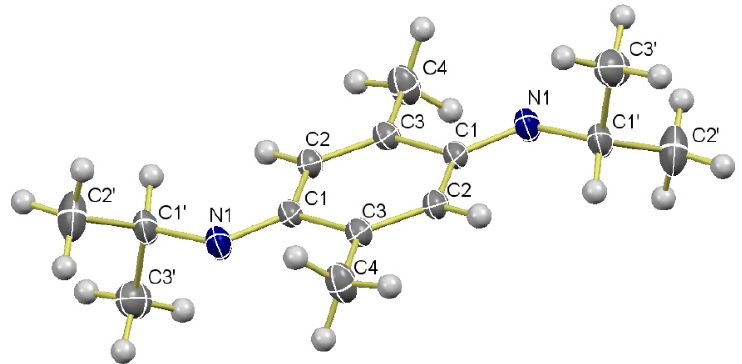
Figure 1. X-ray structure of 8a (ellipsoids at the 30% probability level).